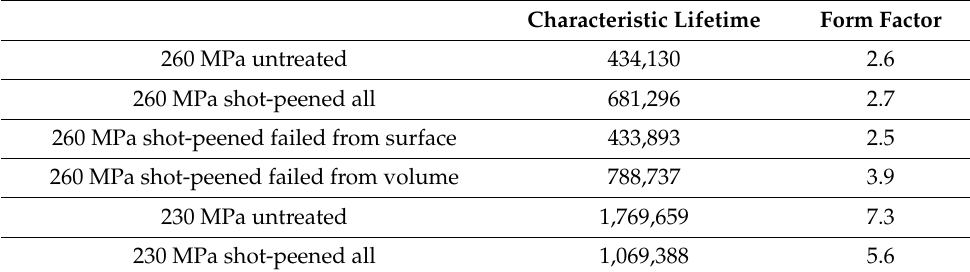
Table 2. Lifetimes of the different conditions and